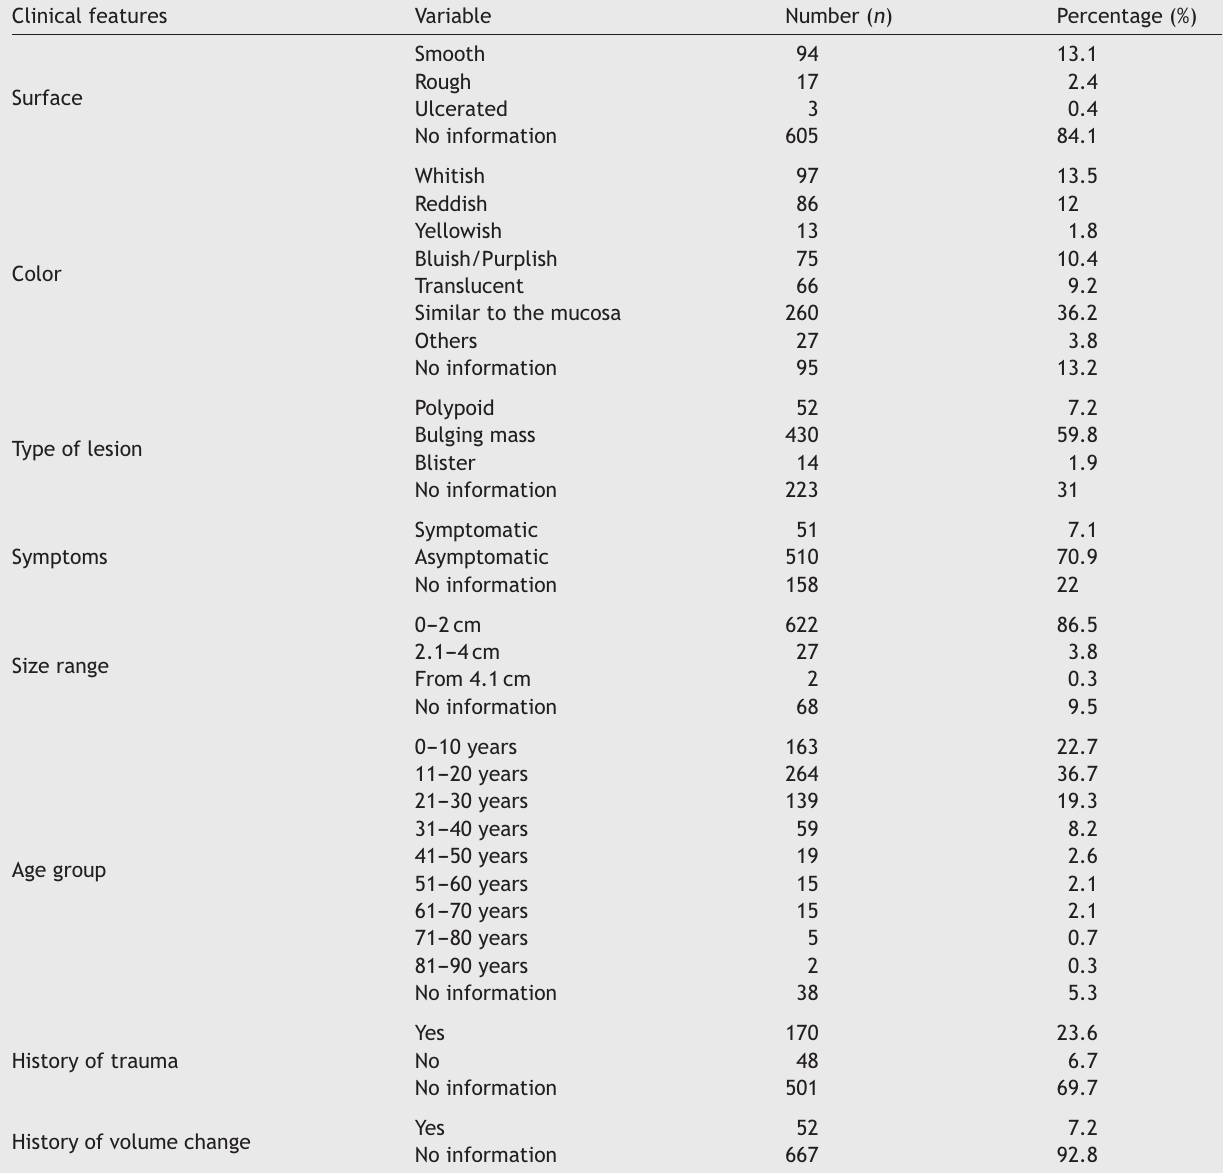
Distribution of absolute and relative frequencies regarding clinical features of oral